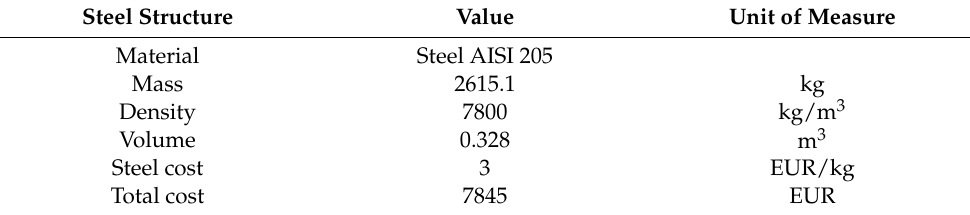
Table 5. Steel structure cost estimation.